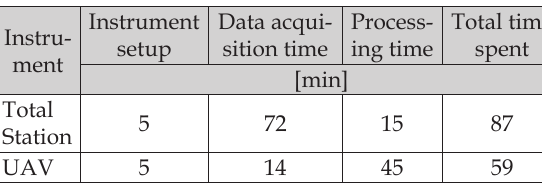
Table 5. Analysis of project execution